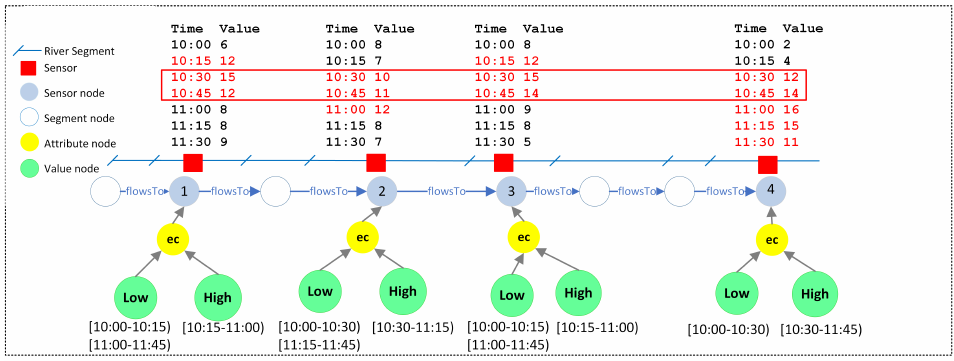
Figure 3. Transportation Network Continuous Path for ec = High